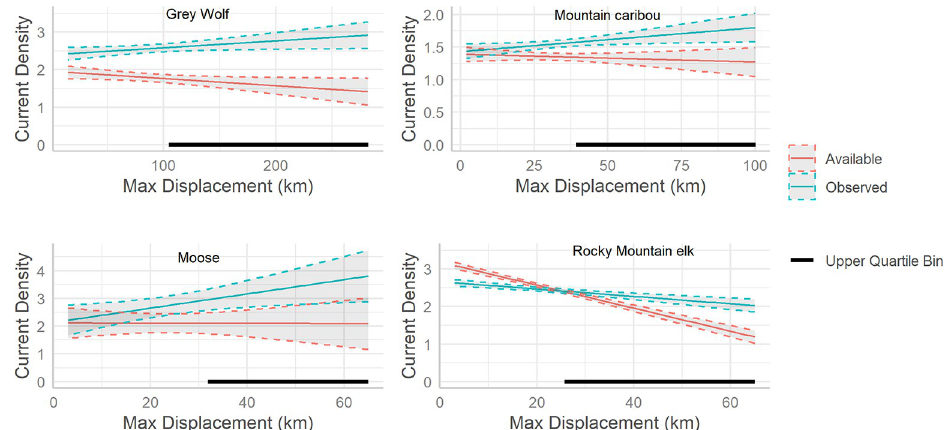
Fig 6. Predicted interactions from the species-specific linear mixed effects models of current density. Solid lines depict predicted mean current density for observed and available locations across the range of individual maximum displacement distances. Predictions were generated from a linear mixed effects model of current density with individual as a random effect and a fixed effect interaction between case (observed or available location) and individual maximum displacement distance. Dotted lines depict 95% confidence intervals; solid black lines indicate the max displacement distances in the upper quartile bin (i.e., the long-distance movers). Preference for areas with higher current density is suggested when current density values at observed locations are greater than at available locations.